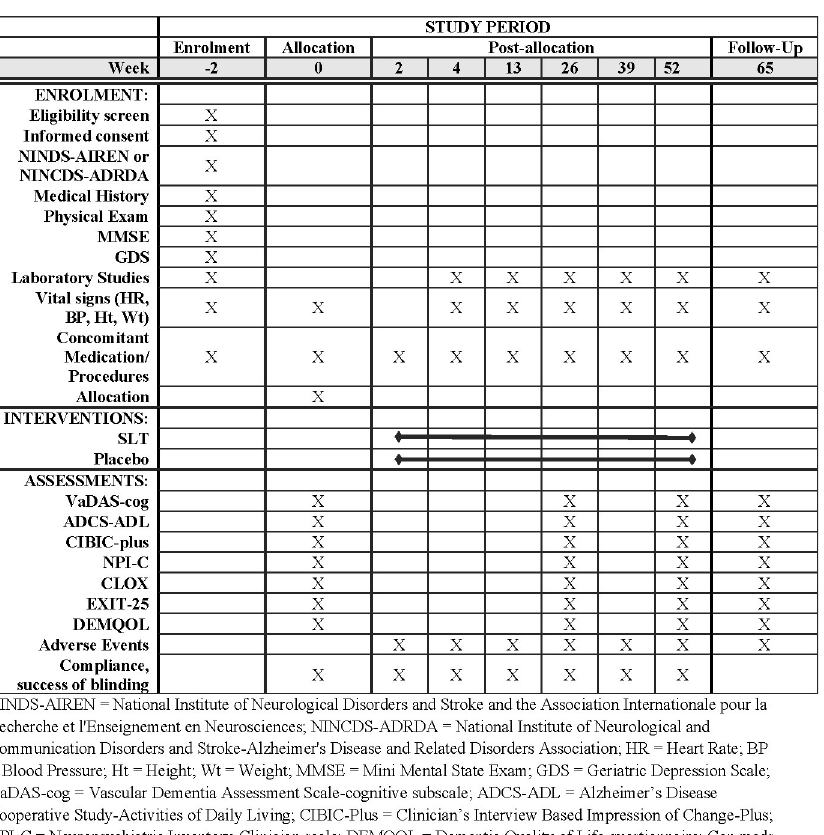
Fig 1. Schedule of enrolment, assessments, and